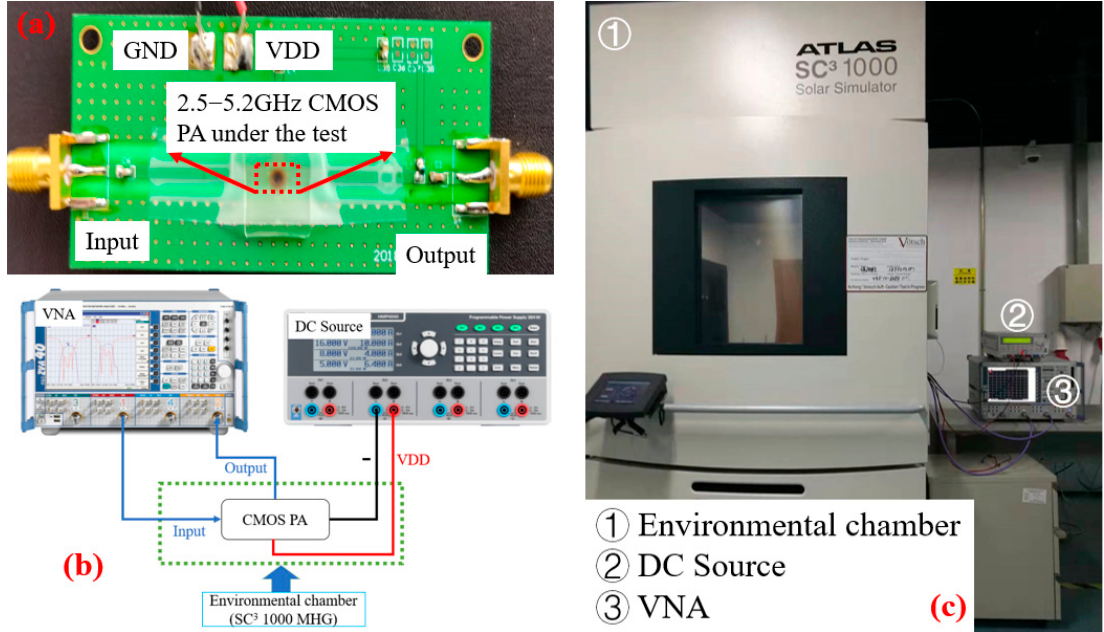
Figure 2. The photograph of the ( a ) object to be measured; ( b ) connection diagram of the measurement; ( c ) physical diagram of the measurement.